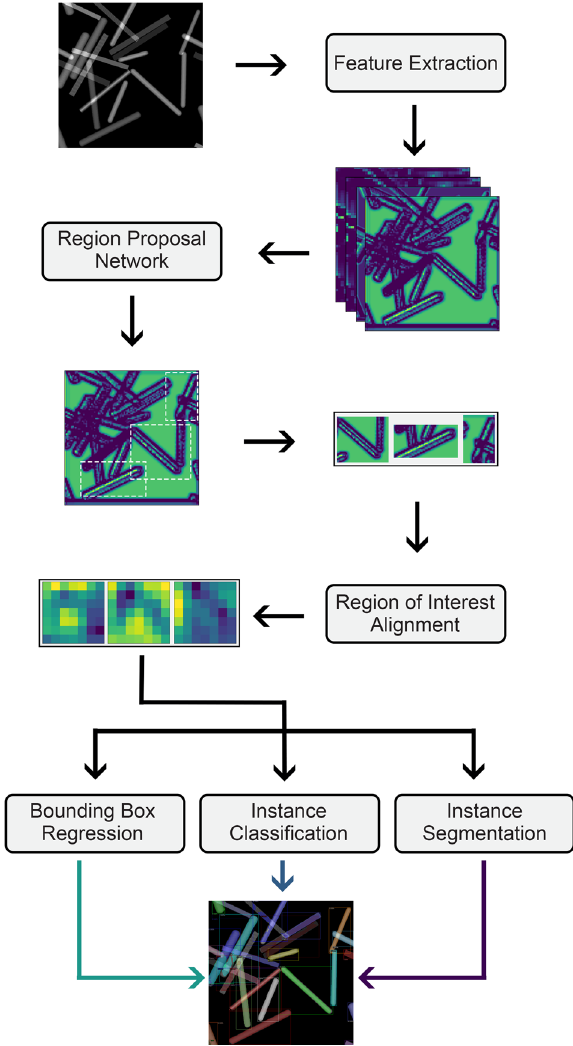
Fig. 10 Basic work fl ow of the Mask R-CNN algorithm. The input image is processed by different network components to extract high-level features, region of interests for prediction of bounding box, classes and masks.